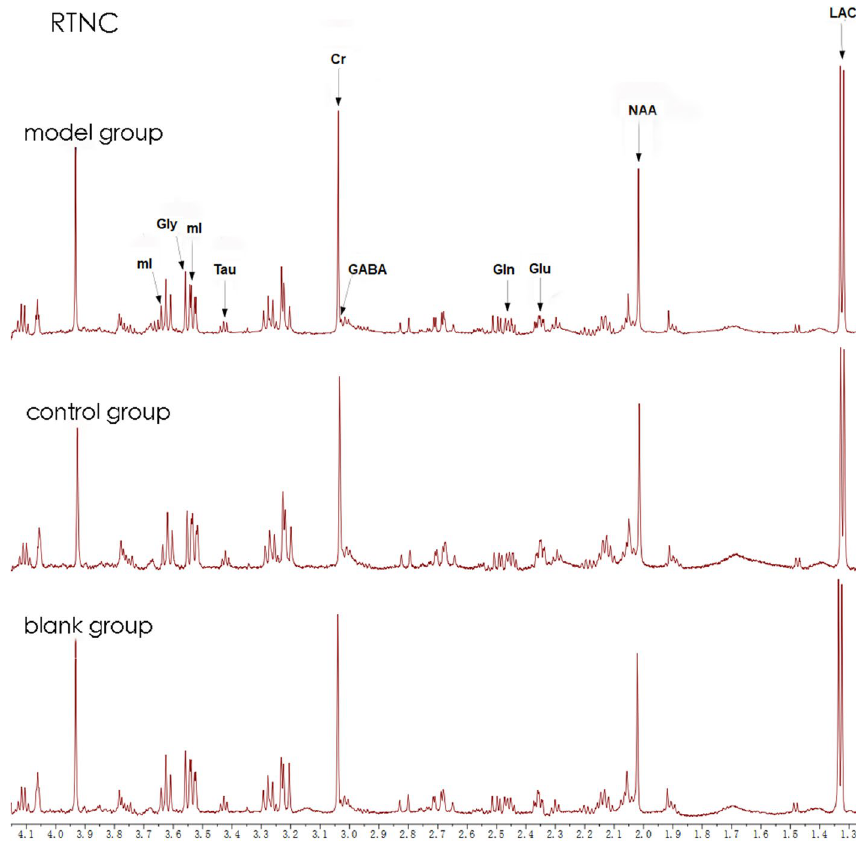
Fig. 1 RTNC MRS image of the three groups sample graph, blank (14 mg), control9 (14 mg), model (18